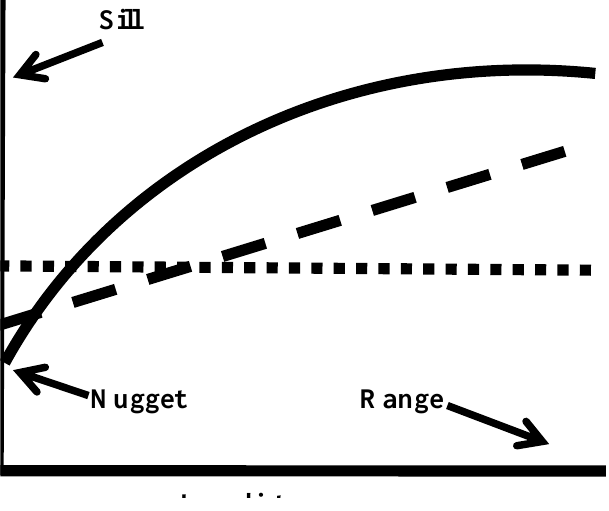
Figure 1. Variogram illustrates relationship of distance between paired observations (lag distance) and variance, and variogram analysis is used to determine three parameters (―Nugget‖, ―Range‖, and